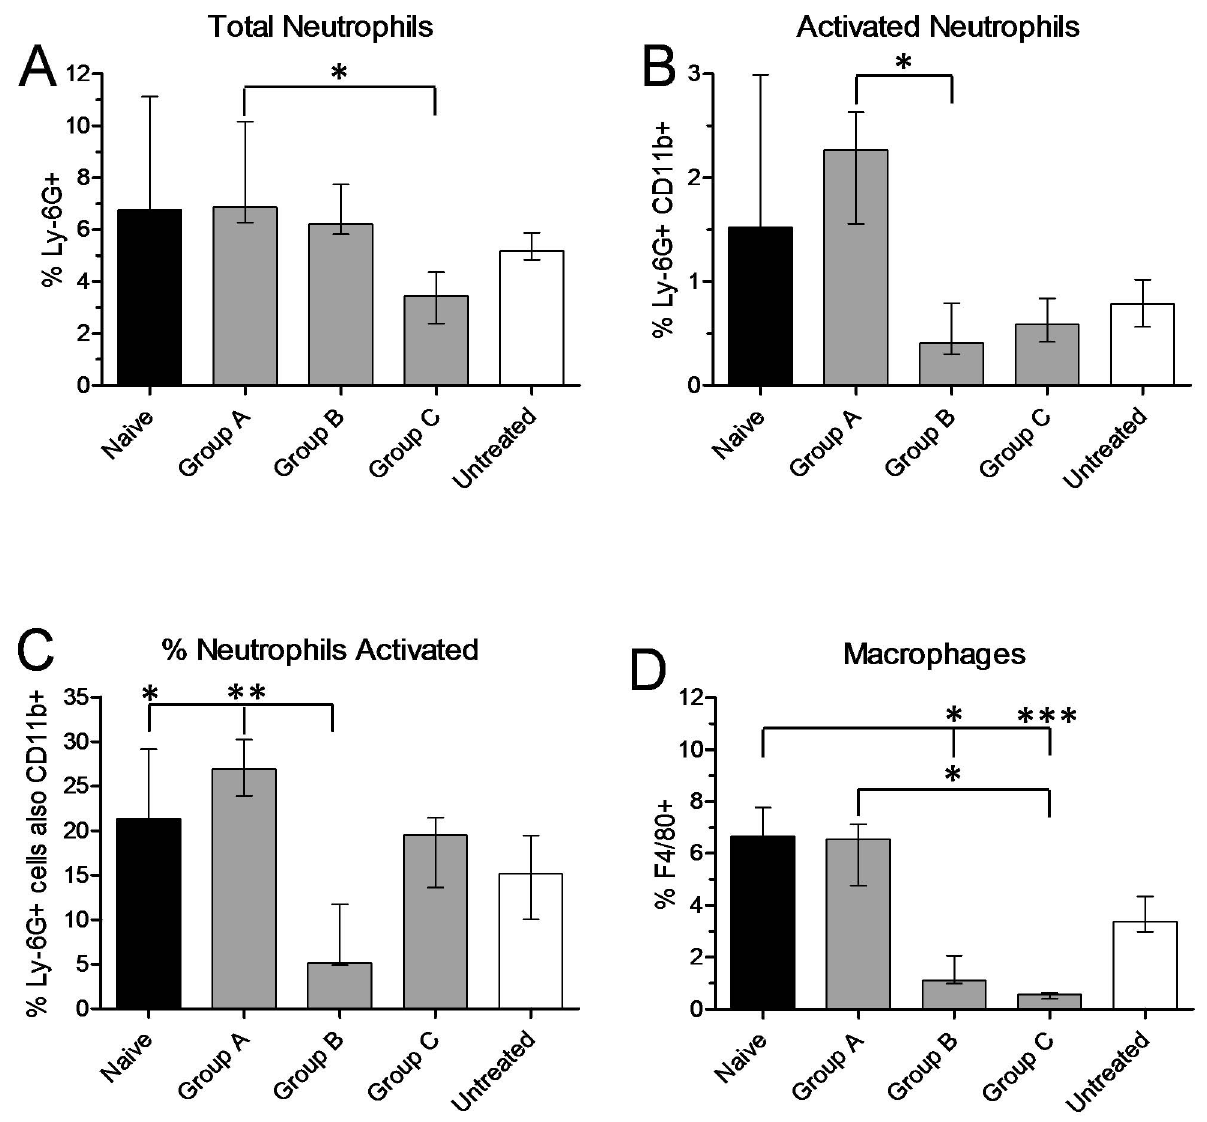
Figure 6. Long-term exposure to fleas attenuates the inflammatory response to flea bites. Flow cytometry quantitation of total neutrophils, expressed as the percentage of Ly-6G + cells of all cells counted ( A ); activated neutrophils, expressed as the percentage of Ly- 6G + CD11b high cells of all cells counted ( B ); % neutrophils activated, expressed as the percentage of all Ly-6G + cells also expressing high levels of CD11b ( C ); and macrophages, expressed as the percentage of F4/80 + cells of all cells counted ( D ). Graphs compare a naı¨ve group of 10 mice exposed to fleas for the first time to mice that had received three different flea exposure regimes (Groups A, B, C; see Methods and Table 1; n=5 per group). The untreated group represents 6 mice that had never been exposed to fleas. Bars show median percentages with interquartile range. Median percentages were compared by Kruskal-Wallis nonparametric ANOVA followed by Dunn’s multiple comparison test. *0.01 , P # 0.05, **0.001 , P # 0.01, ***P ,